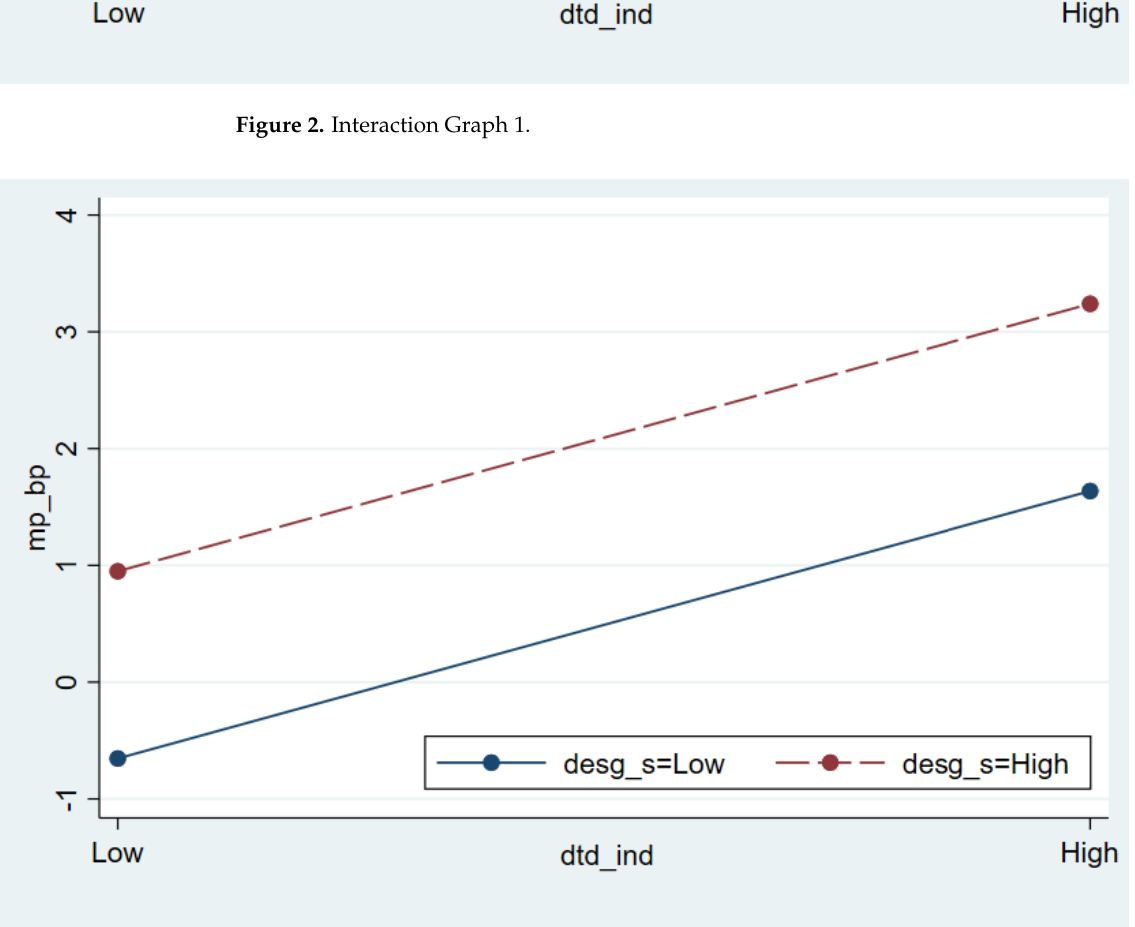
Figure 3. Interaction Graph 2.